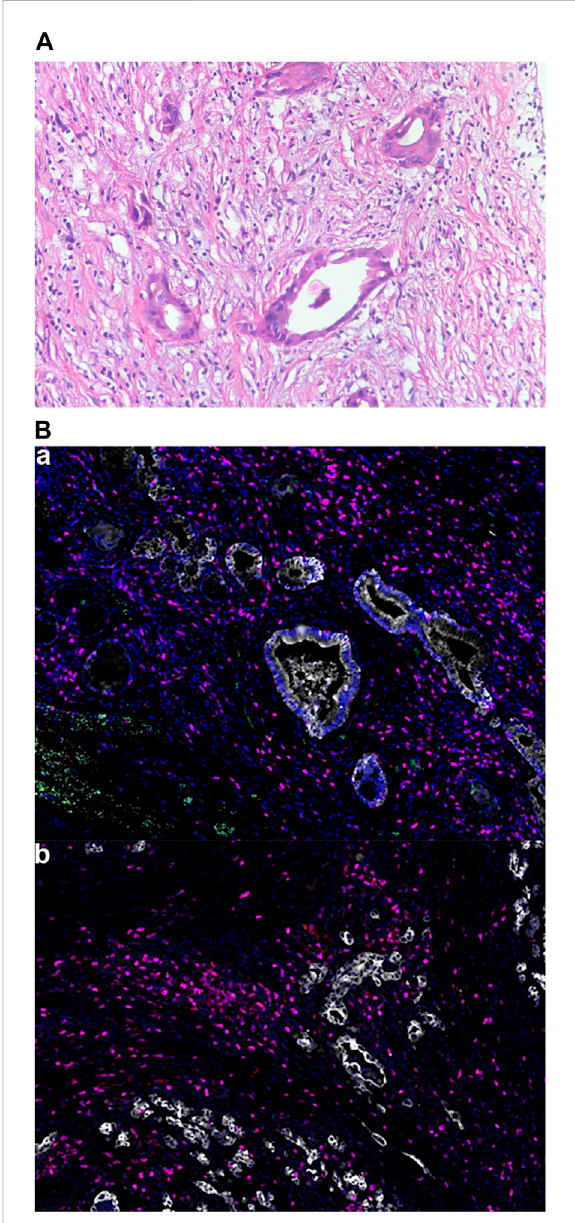
FIGURE 2 Tumor pathological fi ndings. (A) Hematoxylin and eosin staining of the patient ’ s tumor. Magni fi cation, x200; (B) Multiple immuno fl uorescence of the TME: (a): Green for PD-1; Yellow for PD-L1; Pink for CD8; Cyan for CD68; Red for CD163. Magni fi cation, x200. (b): Pink for CD3; Red for CD4; Green for CD20; Cyan for CD56; Yellow for FoxP3. Magni fi cation,